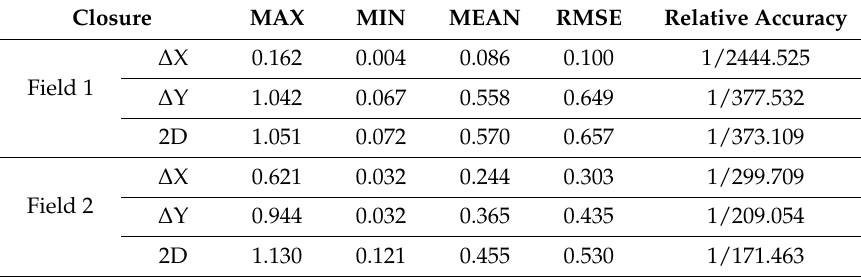
Table 3. Basic Attributes of the Fields. Table 5. Statistics of PDR correction positioning (unit: m).